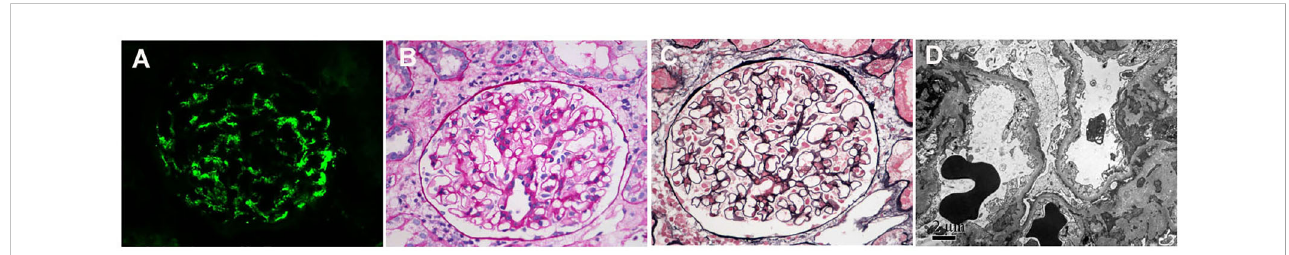
FIGURE 1 Immuno fl uorescence, light microscopy, and electron microscopy in patients with minimal change disease (MCD)-immunoglobulin A nephropathy (IgAN). (A) Immuno fl uorescence of immunoglobulin A (IgA). (B) Periodic acid – silver methenamine. (C) Masson ’ s trichrome (PAM – Masson) staining. (D) diffuse effacement of podocyte foot processes under electron microscopy. (A – C) : original magni fi cation ×400; (D) : original magni fi cation